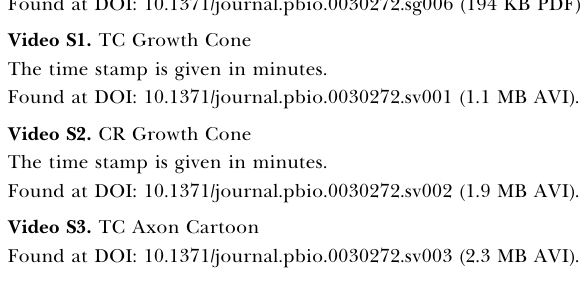
Figure S6. Density of Branch Points in Imaged Mice Matches That in Control Mice To control for possible deleterious effects of chronic imaging, we examined perfusion-fixed, in vivo imaging-naı¨ve mice ( n ¼ 3). The density of branch points in these control mice was not different than that of imaged mice at P8 ( p ¼ 0.88) and P14–P15 ( p ¼ 0.63). Time stamps in hours. Error bars represent the